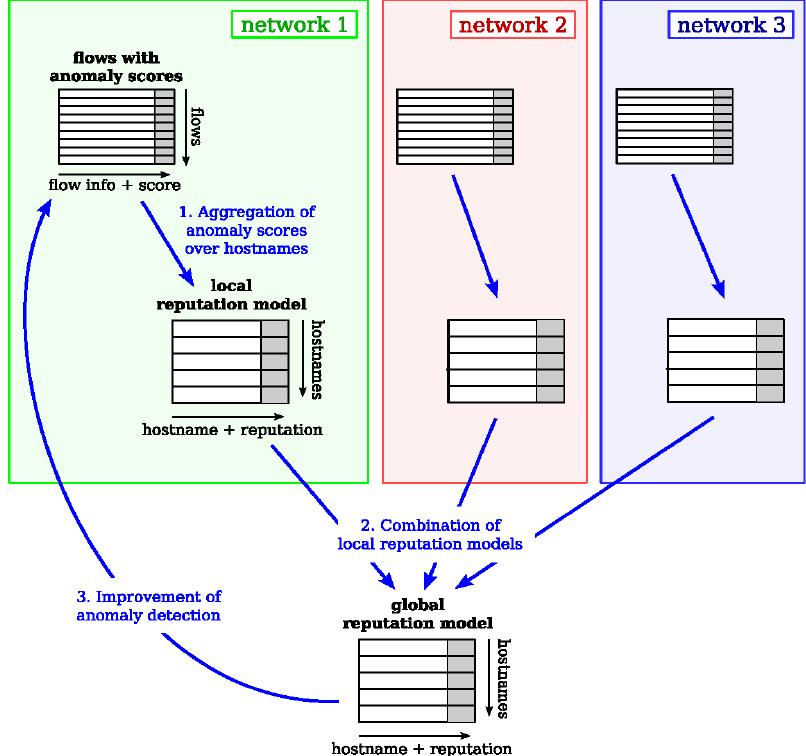
Figure 2. Overview of the global reputation model (GRM) illustrated on three networks.